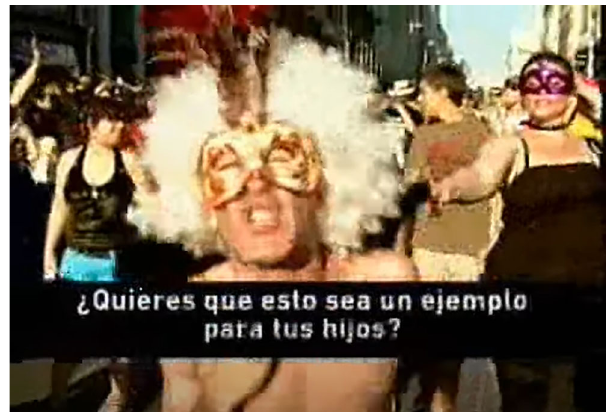
Figure 1. An advertisement broadcast on Intereconomía TV channel on the occasion of Gay Pride, taken from ablogsiteonline. (Originalsource: LasMalasLenguas (IntereconomiaTV,2009).)Translatedtextfromthead:Doyou want this to be an example for your children?.